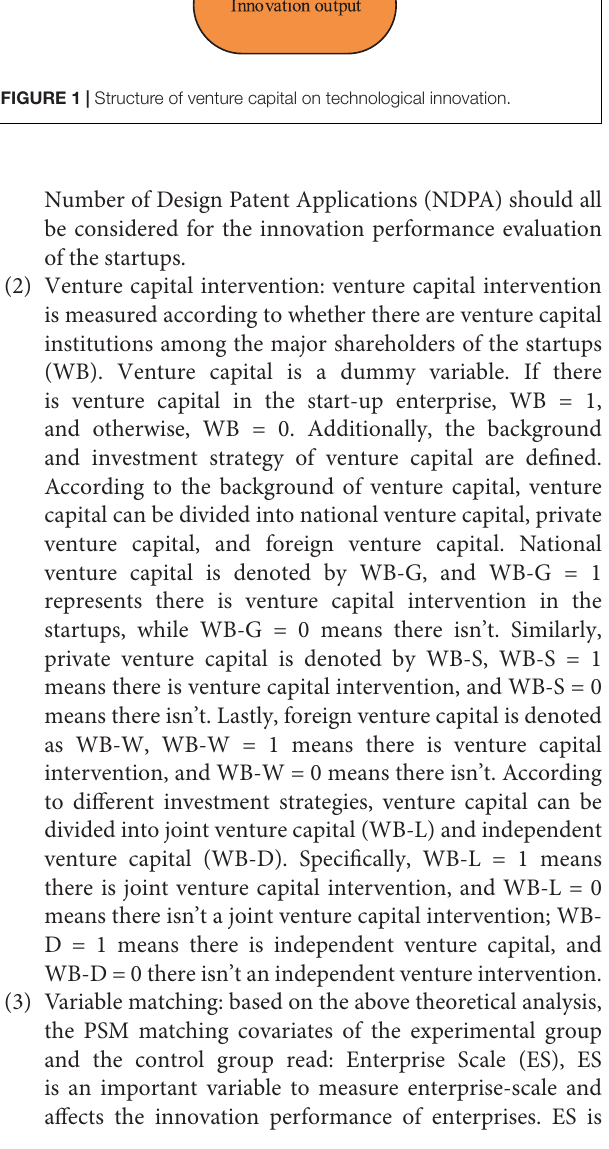
FIGURE 1 | Structure of venture capital on technological innovation.